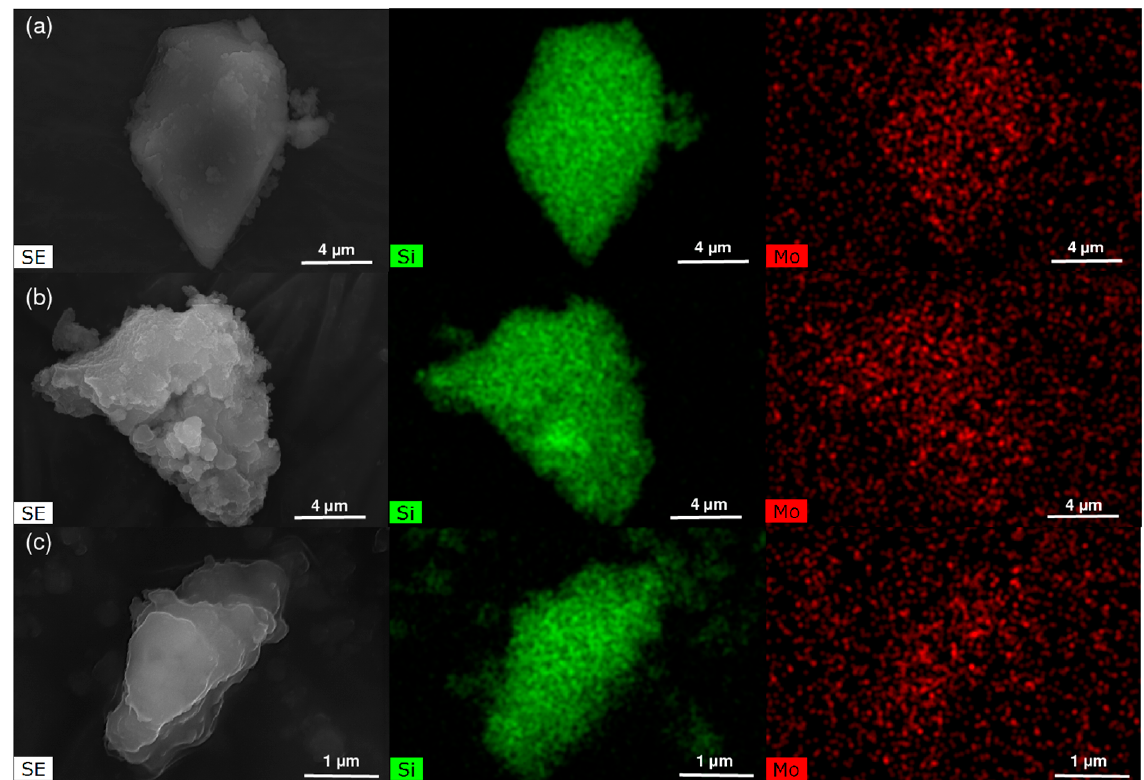
Figure 3. SEM images and elemental mappings (Si (green); Mo (red)) of Mo-TUD(IWI-acac) ( a ), Mo-TUD(HT) ( b ), and Mo-hierBEA ( c ).